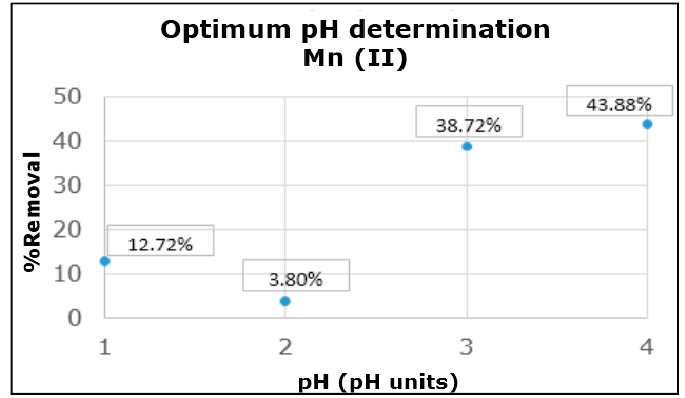
Figure 2. Optimum pH determination of the CP for Mn (II) removal.